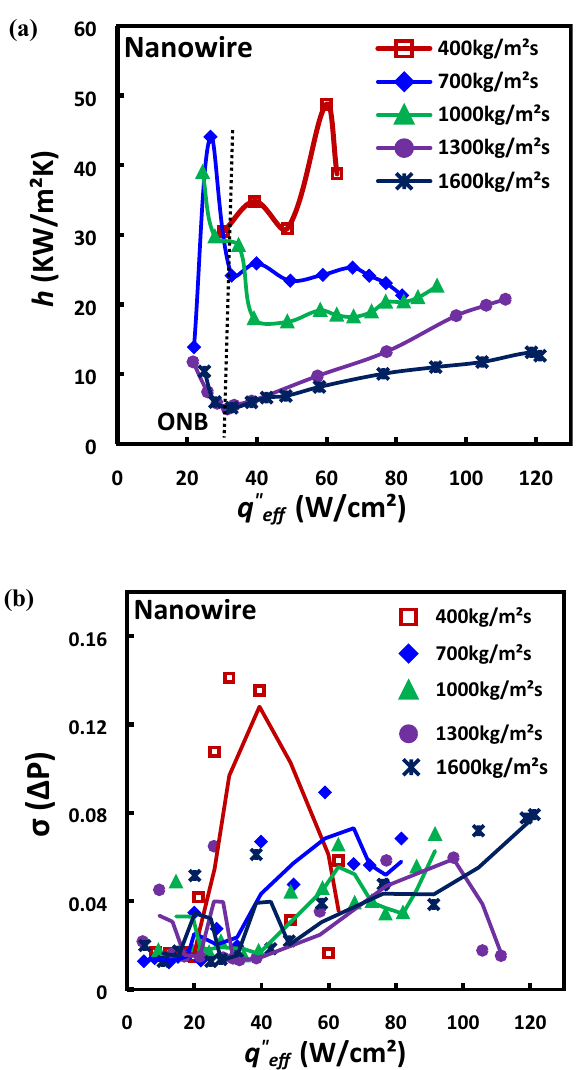
Figure 11. Effects of mass flux in flow boiling SiNW microchannels on ( a ) heat transfer coefficient curve; ( b ) flow boiling instabilities (standard deviation of pressure drop